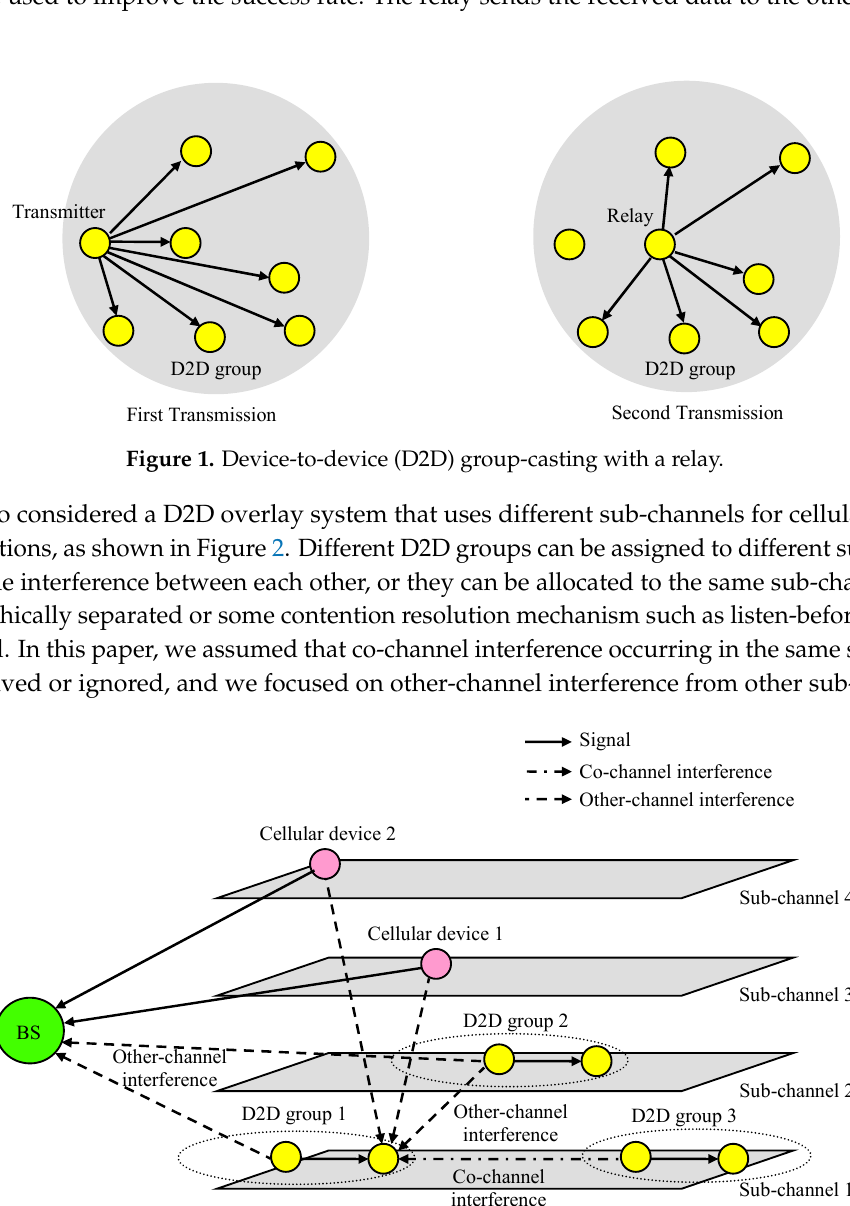
Figure 2. Other-channel interference.